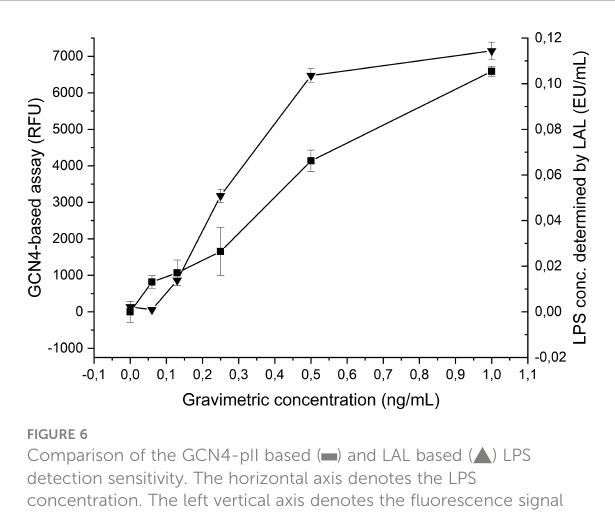
FIGURE 6 Comparison of the GCN4-pII based ( ▀ ) and LAL based ( ▲ ) LPS detection sensitivity. The horizontal axis denotes the LPS concentration. The left vertical axis denotes the fl uorescence signal for GCN4-pII based detection, and the right axis denotes the LPS concentration determined by